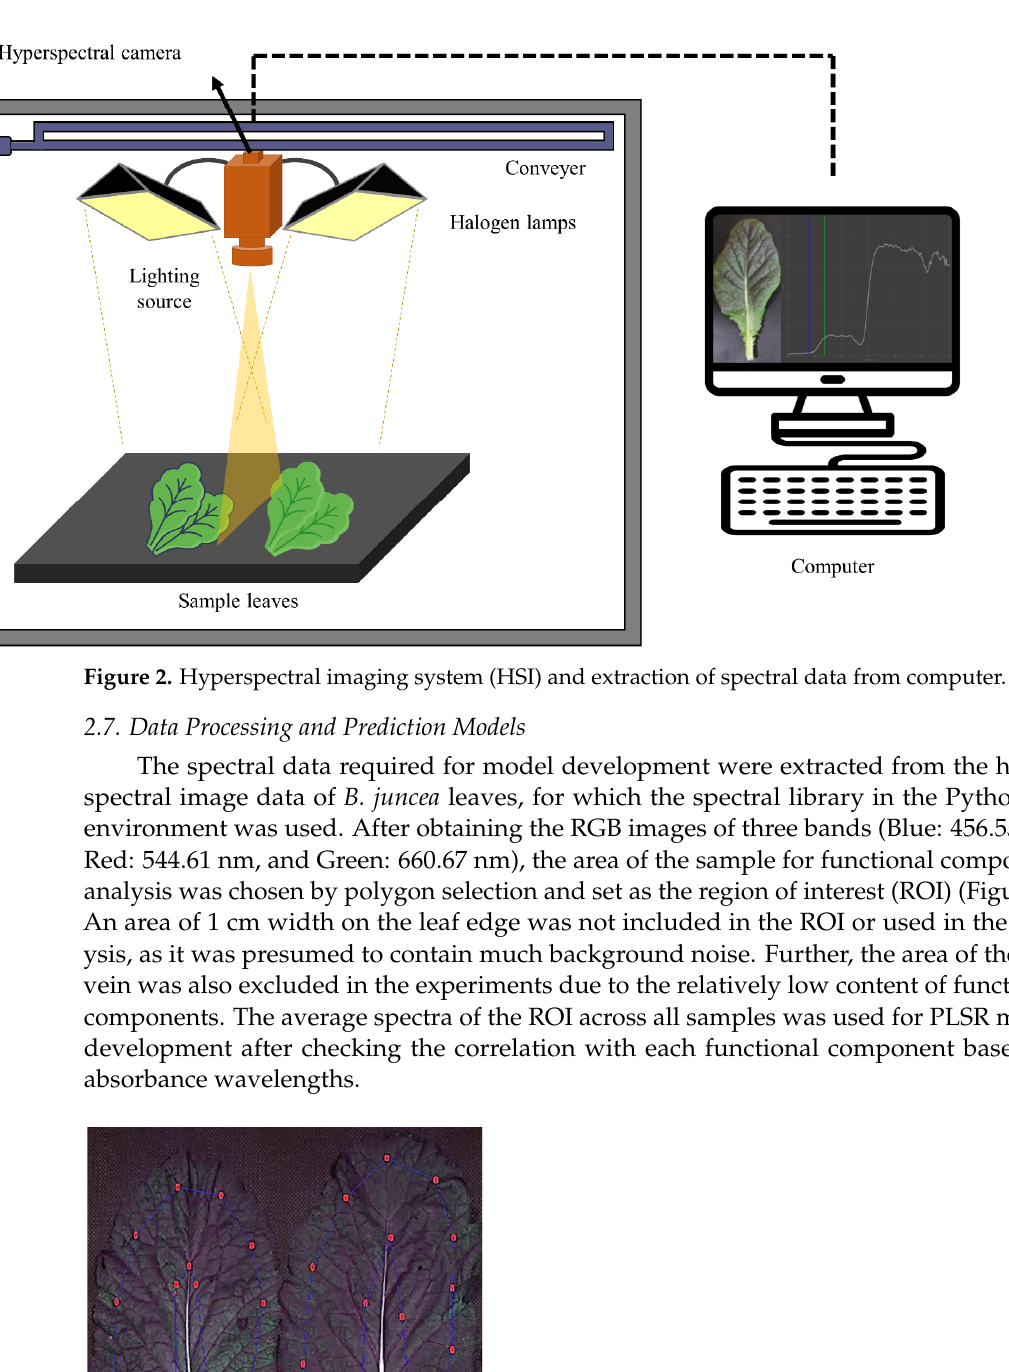
Table 1. MicroHSI™ 410 -SHARK specifications.